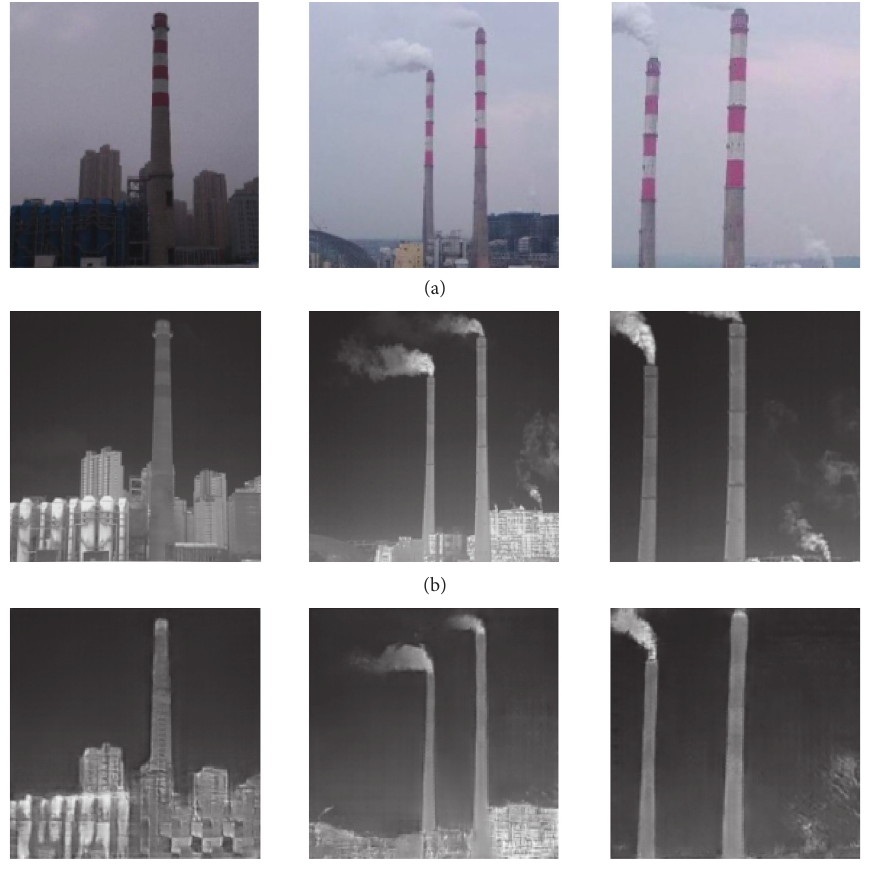
Figure 6: Examples of infrared-generated images of chimneys produced on the basis of the I-GANs algorithm. (a) Visible images. (b) Real infrared images. (c) Infrared-generated